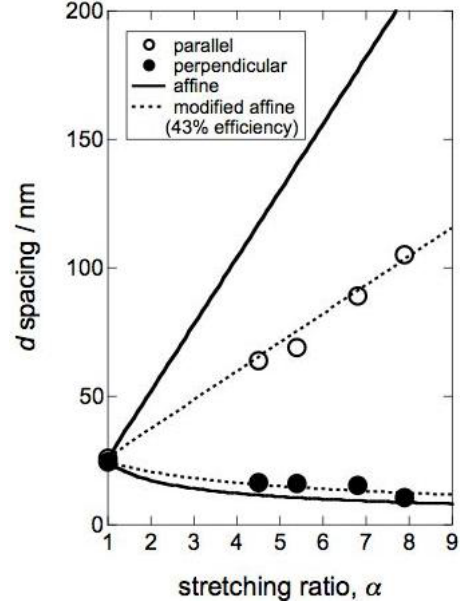
Figure 8. Change in the domain spacing d along with the uniaxial stretching. The solid curves indicate behaviors by assuming the affine deformation and that the total volume of the sample does not change during the stretching, based on Equations (1) and (2). The dotted curves are the best fits to the data expressed by Equations (3) and (4), the modified affine with k =